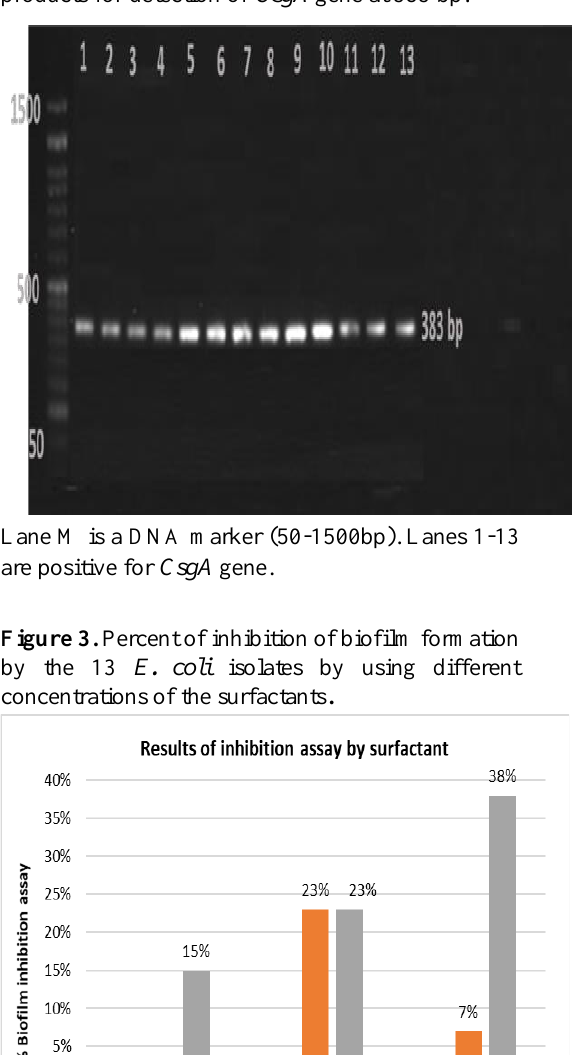
Figure 2. Gel electrophoresis of the PCR –amplified products for detection of CsgA gene at 383 bp.